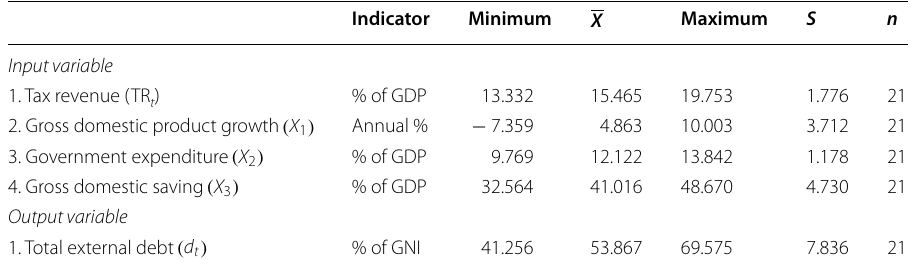
Table 1 Descriptive statistics that include input and output variables to be considered in ANFIS